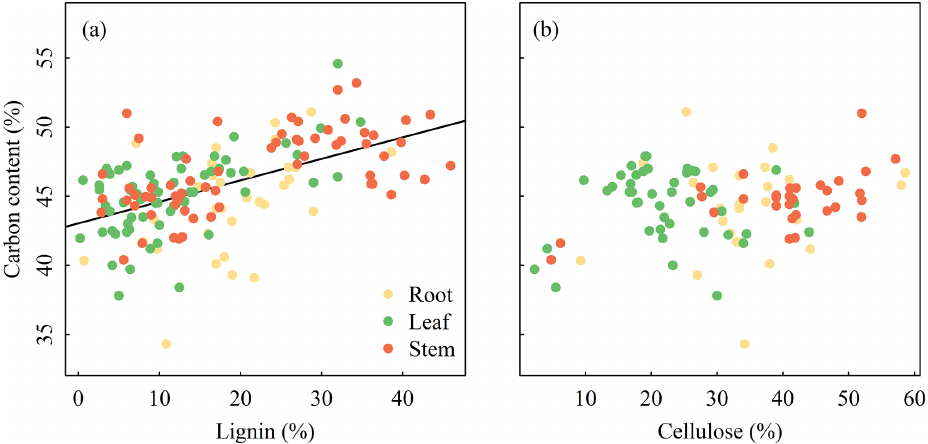
Figure 5. Relationships between plant carbon content and lignin and cellulose among three organs. Plant carbon content increases signifi- cantly with the increasing lignin in plants ( r 2 = 0.29, p <0.001), whereas it is not correlated with the cellulose in